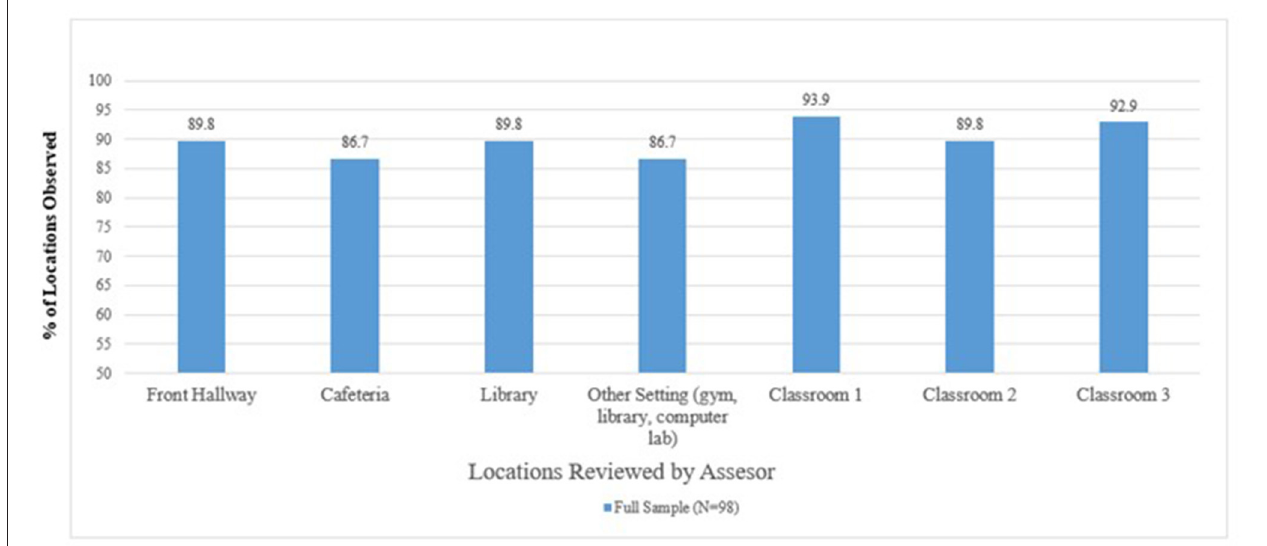
FIGURE 1 | Percentage of locations where crisis plan was observed to be posted by the study assessor. Classrooms 1, 2, and 3 were randomly selected classrooms reviewed by assessor, balancing across different grade levels within the school.